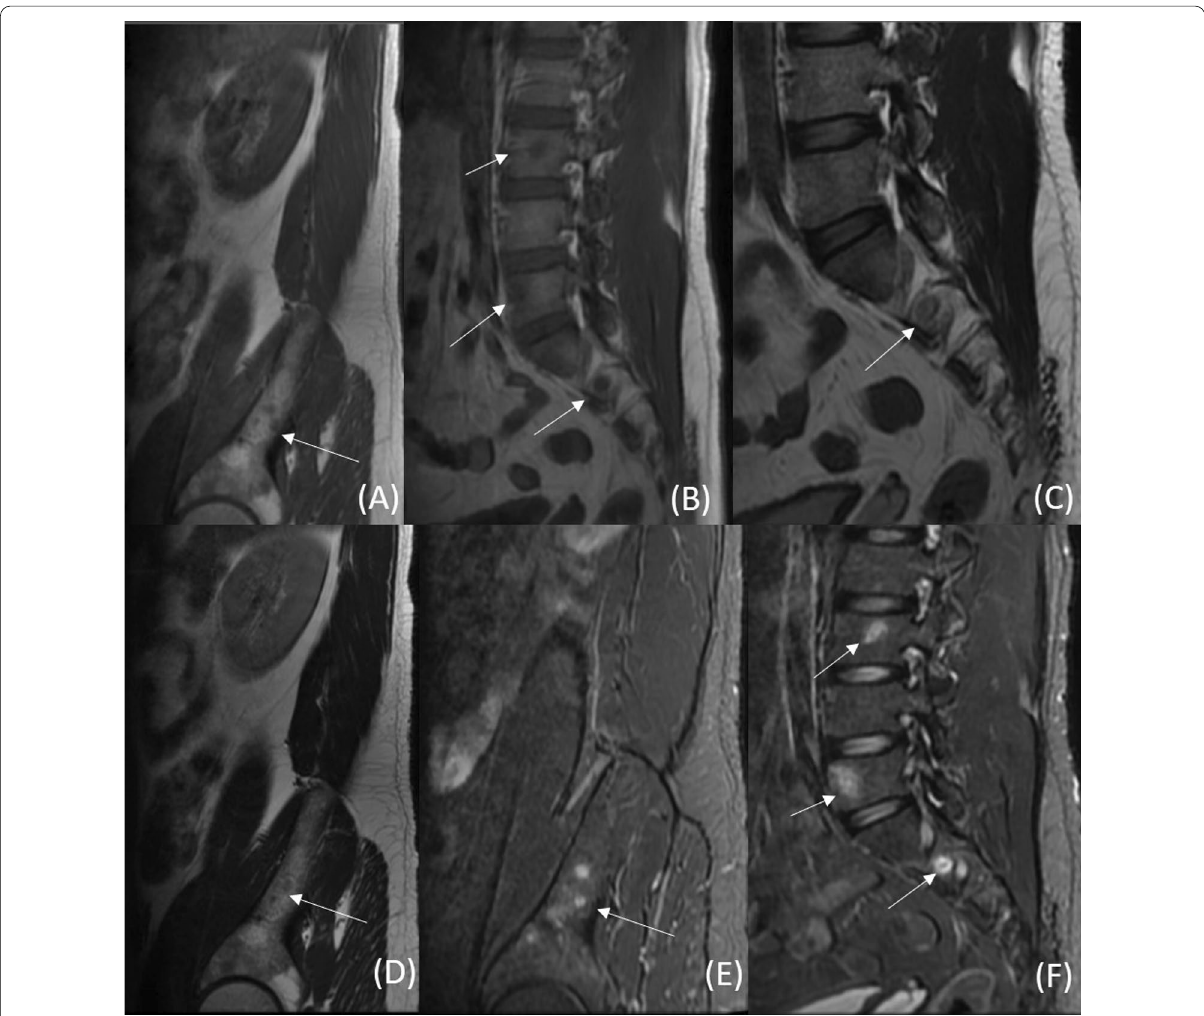
Fig. 8 Multifocal skeletal tuberculosis with subcutaneous tubercular deposits. MRI spine of a 35-year-old male shows multiple lesions (white arrows) in lumbar and sacral vertebrae and iliac bone. The lesions are hypointense on T1W ( A and B ) and T2W images ( C and D ) and hyperintense on STIR ( E and F